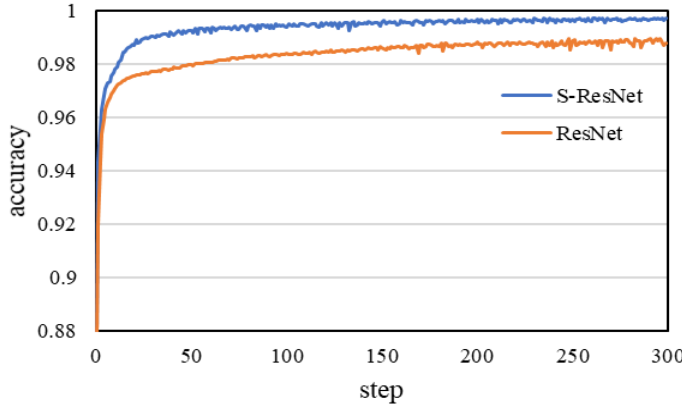
Figure 13. The change of the accuracy of the two IDSs when training models.